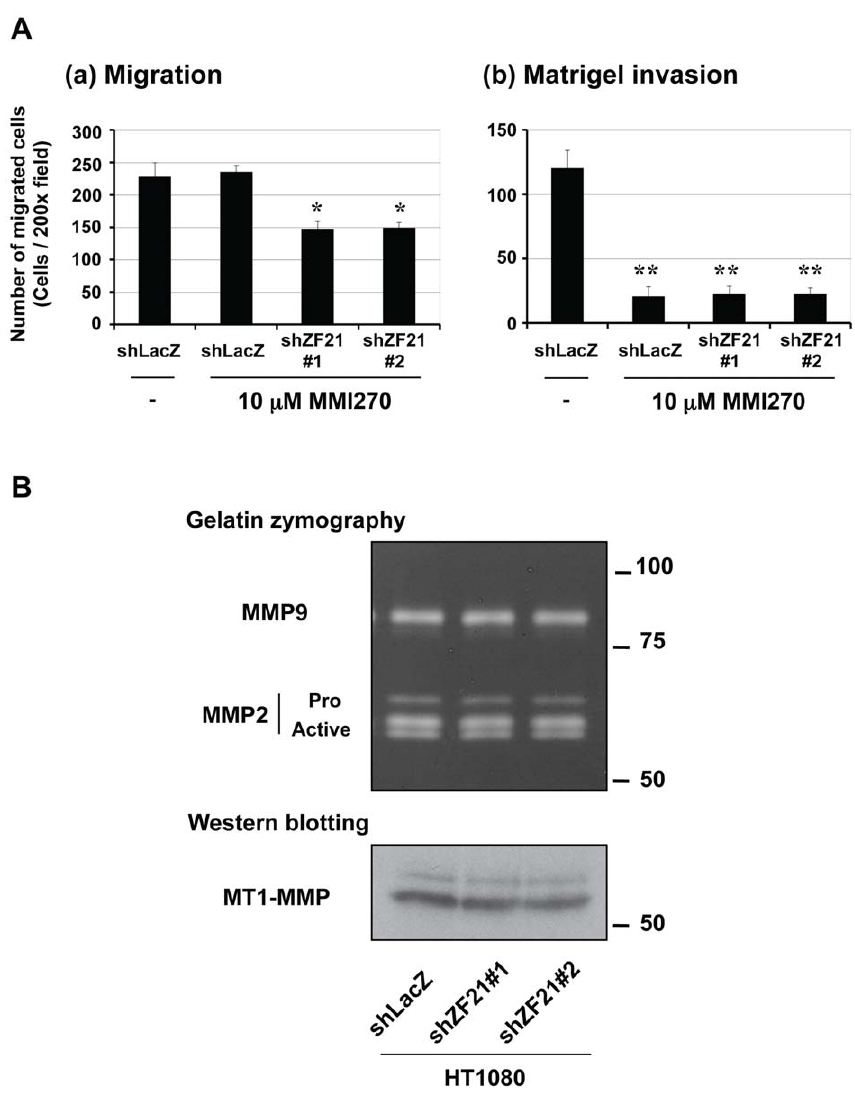
Figure 3. ZF21-mediated matrigel invasion was suppressed by MMP inhibition. A. In the presence of 10 m M MMI270, the same set of cells indicated in Fig. 1D was subjected to migration (a) and matrigel invasion assays (b). Error bars indicate the means 6 S.D. (n=3).*, p , 0.01 **, p , 0.005 (Student’s t test). B. The cultured media of HT1080 cells expressing shLacZ or shZF21 # 1 and # 2 were subjected to gelatin zymography analysis to detect MMP-2 and MMP-9. The same samples indicated in Fig. 1A were subjected to the Western blot analysis to detect MT1-MMP using a specific antibody. The expression levels of MT1-MMP in the cells were normalized by those of actin indicated in Fig. 1A.